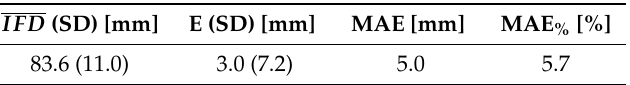
Table 4. Average of the inter-foot distance values with standard deviation ( IFD (SD)), overall error with standard deviation (E (SD)), mean absolute error (MAE) and mean absolute percentage error (MAE % ) during